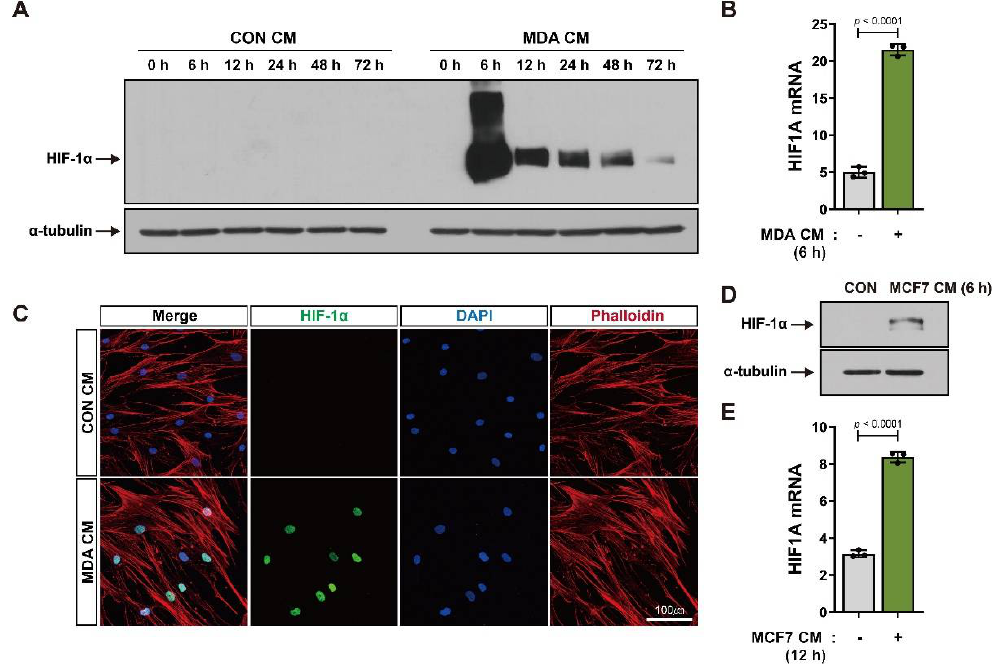
Figure 1. Increase in HIF-1 α expression in BM-MSCs in response to breast tumor-mimicking conditions: ( A , B ) Protein and mRNA levels of HIF-1 α in BM-MSCs treated with the control conditioned medium (CON CM) or conditioned medium from MDA-MB-231 cells (MDA CM) for the indicated times; α-tubulin was used as an internal control for Western blot analysis. ( C ) Immuno- cytochemistry of BM-MSCs treated with CON CM or MDA CM for 6 h; actin was stained red with phalloidin and nuclei were stained blue with DAPI. ( D , E ) Protein and mRNA levels of HIF-1α in BM-MSCs treated with CON CM or conditioned medium from MCF7 (MCF7 CM) cells for 6 h and 12 h, respectively. Results are presented as the mean ± SD. Uncropped Western blot images are available in Figure S1. 3.2. ROS and JAK/Stat3 Signaling Mediate HIF-1α Induction in BM-MSCs in Response to Breast Tumor-Mimicking Conditions The activation of JAK/Stat signaling is associated with the establishment of the tu- mor microenvironment [44,45], and Stats play important roles in regulating the stability of HIF-1α proteins [36,46]. We found that the level of phosphorylated Stat3 increased in BM-MSCs incubated with MDA CM. Stat3 phosphorylation increased at 15 min after MDA CM treatment and declined thereafter (Figure 2A). Ruxolitinib, a selective inhibi- tor of JAK [47], suppressed the increase in Stat3 phosphorylation in BM-MSCs treated with MDA CM (Figure 2B). ROS induces the activation of JAK/Stat signaling [48] and has also been found to regulate the activity and stability of the HIF-1α protein [26,49,50]. N-acetylcysteine (NAC), an ROS inhibitor, suppressed the phosphorylation of Stat3 in BM-MSCs treated with MDA CM (Figure 2C). Ruxolitinib and NAC suppressed the in- crease in HIF-1α expression in BM-MSCs treated with MDA CM (Figure 2D,E). The ele- vated levels of HIF-1α protein in BM-MSCs incubated with MDA CM were more signifi- cantly suppressed with ruxolitinib and NAC co-treatment than with ruxolitinib or NAC treatment alone (Figure 2F). BM-MSCs incubated with MCF7 CM showed increased JAK-mediated phosphorylation of Stat3, and NAC inhibited Stat3 phosphorylation in BM-MSCs (Figure 2G,H). The MCF7 CM-mediated increase in HIF-1α was suppressed in ruxolitinib- or NAC-pretreated BM-MSCs (Figure 2I,J), and co-treatment with ruxolitinib and NAC showed an addictive effect and greatly suppressed MCF7 CM-mediated HIF- 1α expression (Figure 2K). Stat3 and ROS signaling have been shown to mediate the in- crease in HIF-1α transcription in both hypoxic and normoxic conditions [27,28,51]. Nei-